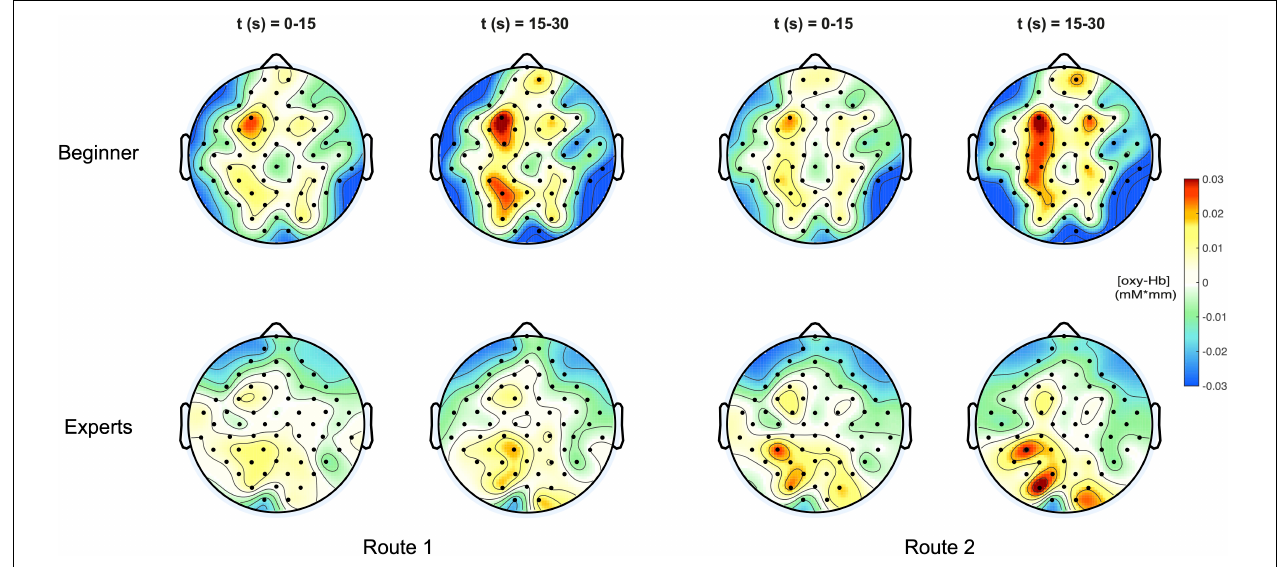
FIGURE 3 | (Top) Topoplots of the mean oxy-Hb concentration changes for beginners during MI of both routes (left side: Route 1 = easy; right side: Route 2 = difficult) and two time windows (0–15 s and 15–30 s). (Bottom) Topoplots of the mean oxy-Hb concentration changes for experts during MI of both routes (left side: Route 1 = easy; right side: Route 2 = difficult) and two time windows (0–15 s and 15–30 s).